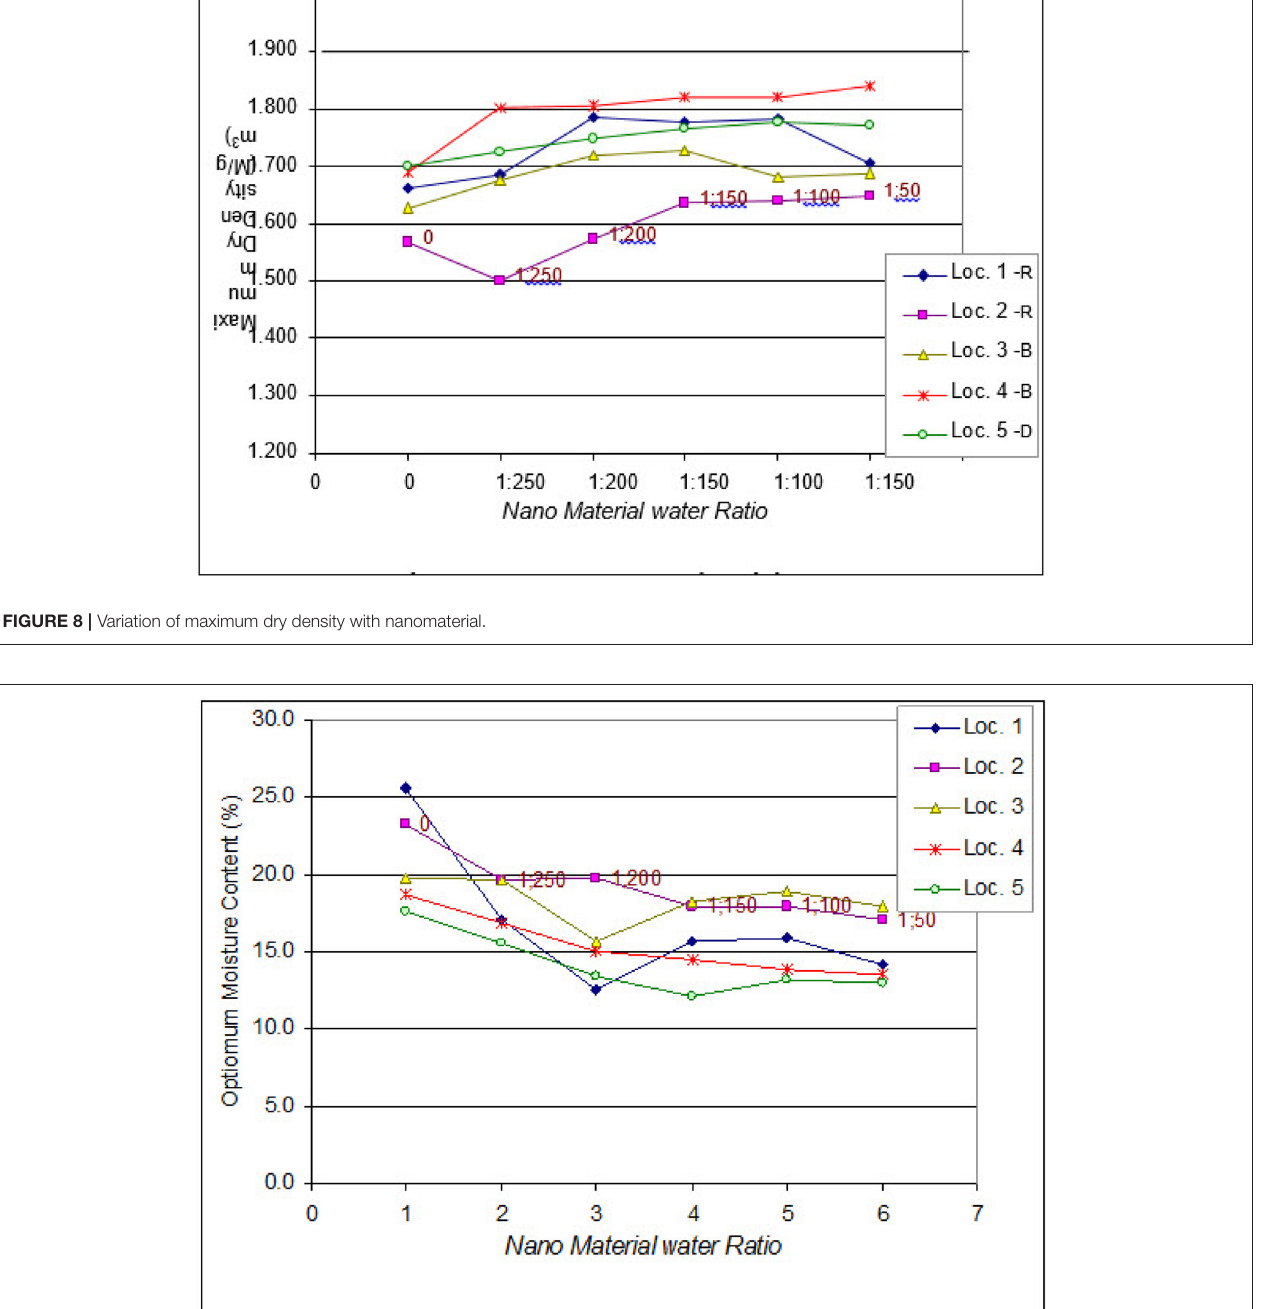
with absorption in accordance with ASTM D 4644 − 08,